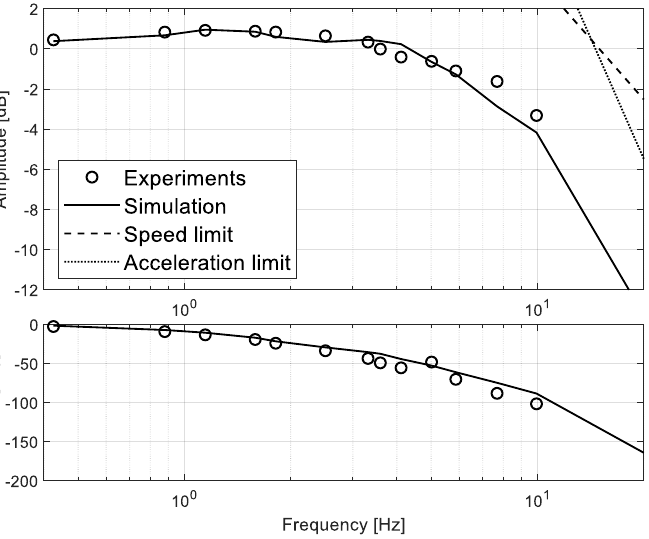
Figure 11. Frequency-domain model validation in AAEP mode: position tracking at 1% maximum demand amplitude (0.5 mm), with 2 kN compressive load.